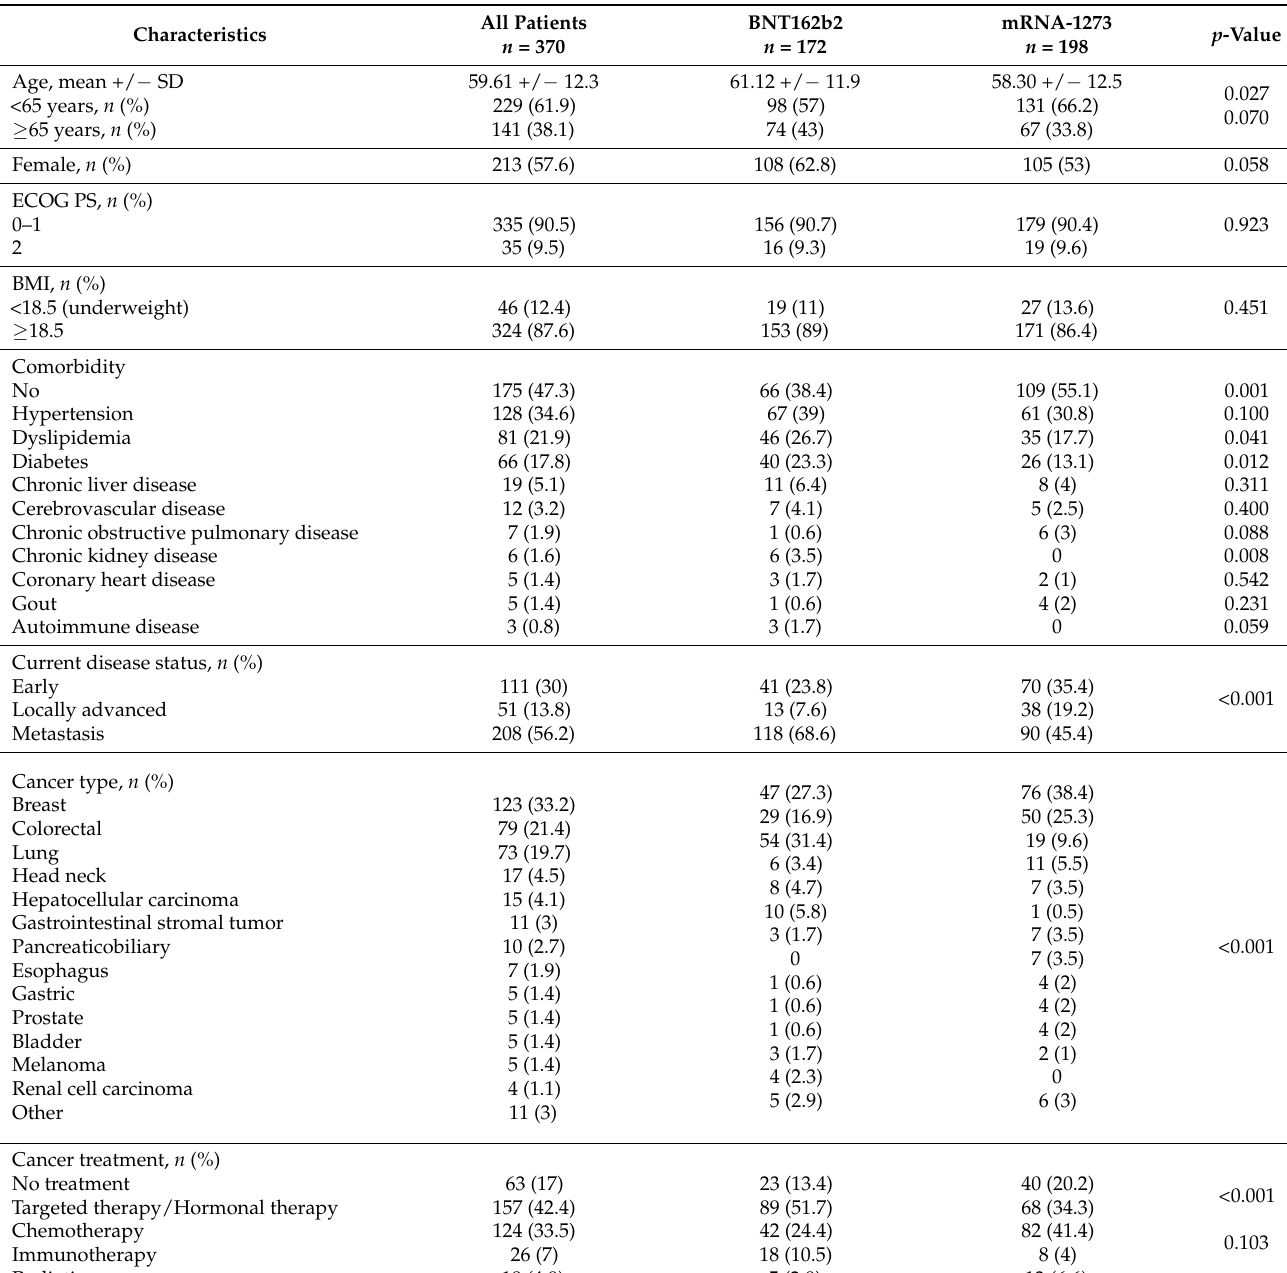
Table 1. Patient demographics and disease